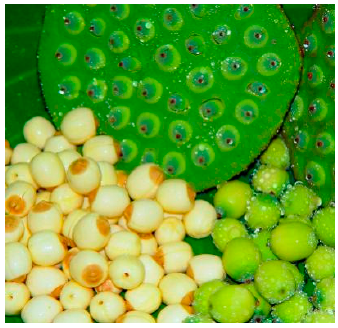
Figure 1. Seeds and seedpods of lotus ( Nelumbo nucifera Gaertn.).